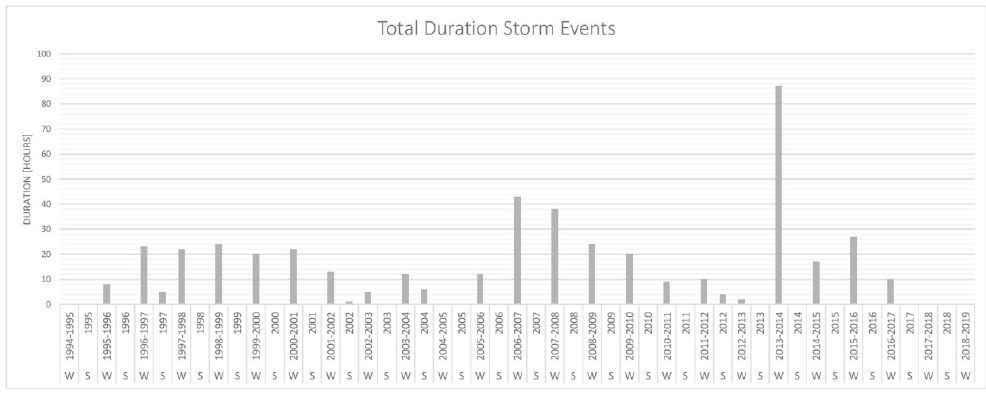
Figure 8. Mean storm durations in the preceding 25 years incident on Dingle Bay.